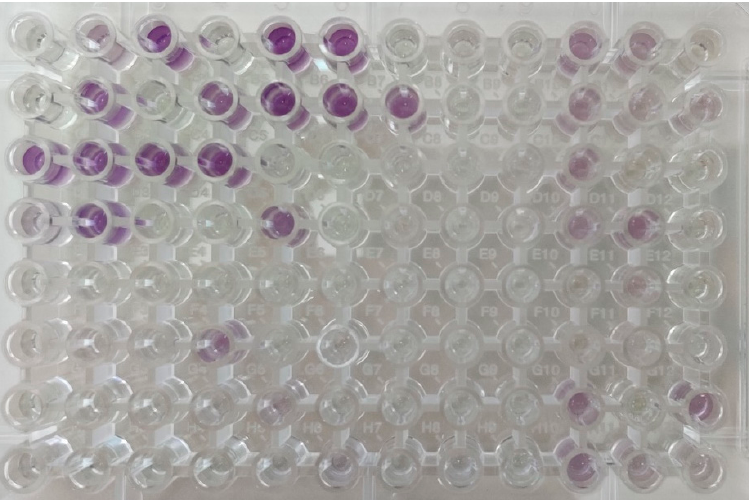
Figure 2. Representative GEN III microplate showing the metabolic fingerprint (color development after 22 h of incubation at 33 °C) of a microorganism based on which its identification is made. after 22 h of incubation at 33 ◦ C) of a microorganism based on which its identification is made. 3.3. Lactic Acid Bacteria Microecosystem of Raw Sheep’s Milk, Feta and 3.3. Lactic Acid Bacteria Microecosystem of Raw Sheep’s Milk, Feta and Kefalograviera